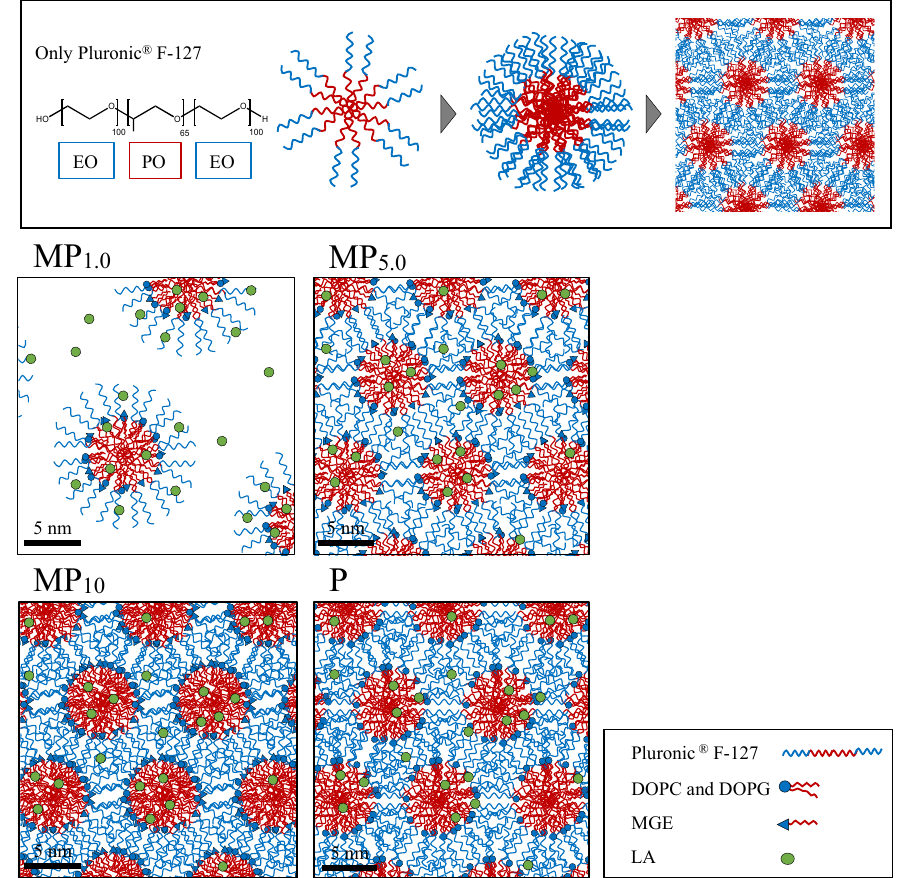
Figure 9. Schematic representation of the morphology of the prepared formulations.